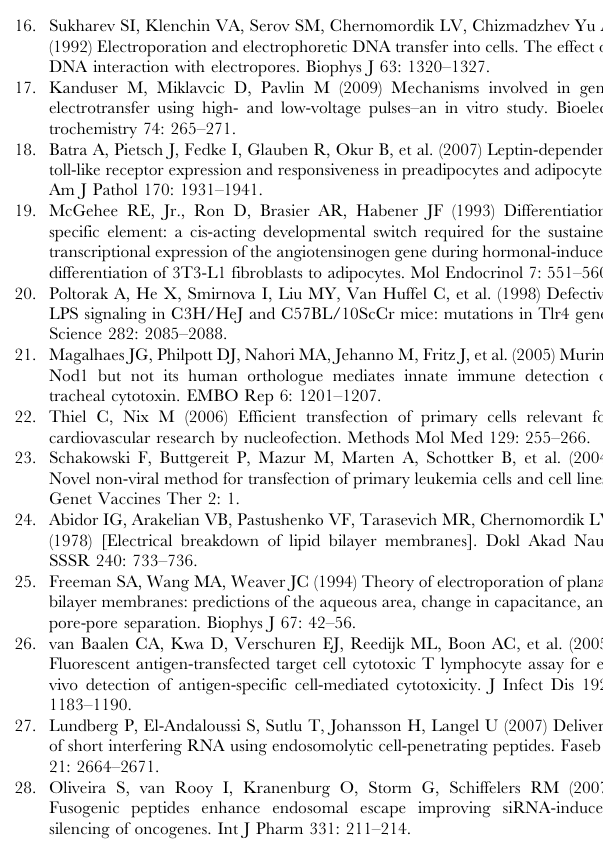
Figure S1 Composition of the ELPorator 1000 device. Elec- tronic composition of the output stage of the HV module. MC, microcontroller; OC, optical coupler; RG, gate resistor; T, transistor; RS, shunt resistor, D, diode; Rel, relay; C, capacitor (upper panel). Picture shows the complete ELPorator 1000 system (lower panel). Outputs of both modules are parallel connected via internal diodes to prevent current flow from one module to the other. The signal to trigger the LV module is generated by the microcontroller of the HV module and sent via a control cable at the backside of the module.